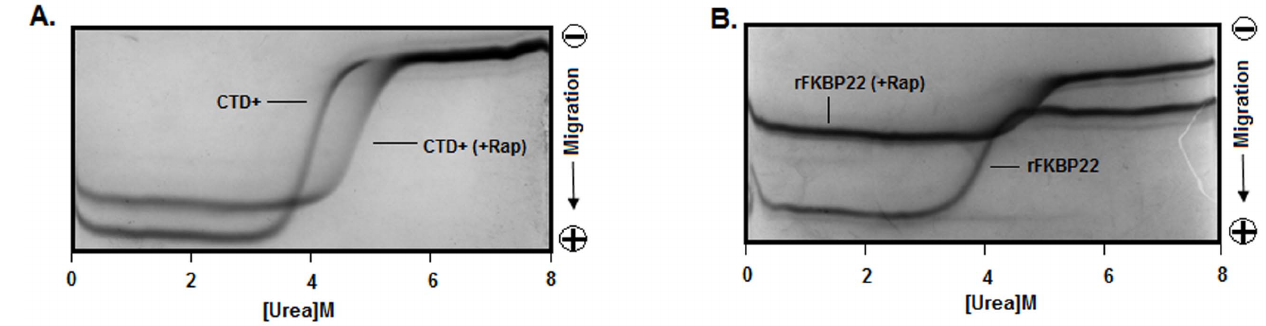
Figure 3. Mobility of the indicated native (A–B) proteins across the transverse urea gradient polyacrylamide gel.